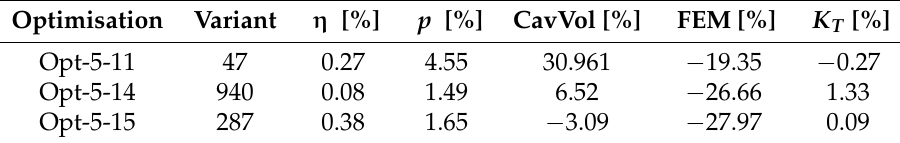
Figure 22. Group 3. ( a ) Rake development in Group 3 of Opt-5; ( b ) K T development in Group 3 of Opt-5. Table 13. Performance of optimal solutions, relative to manual design performance.